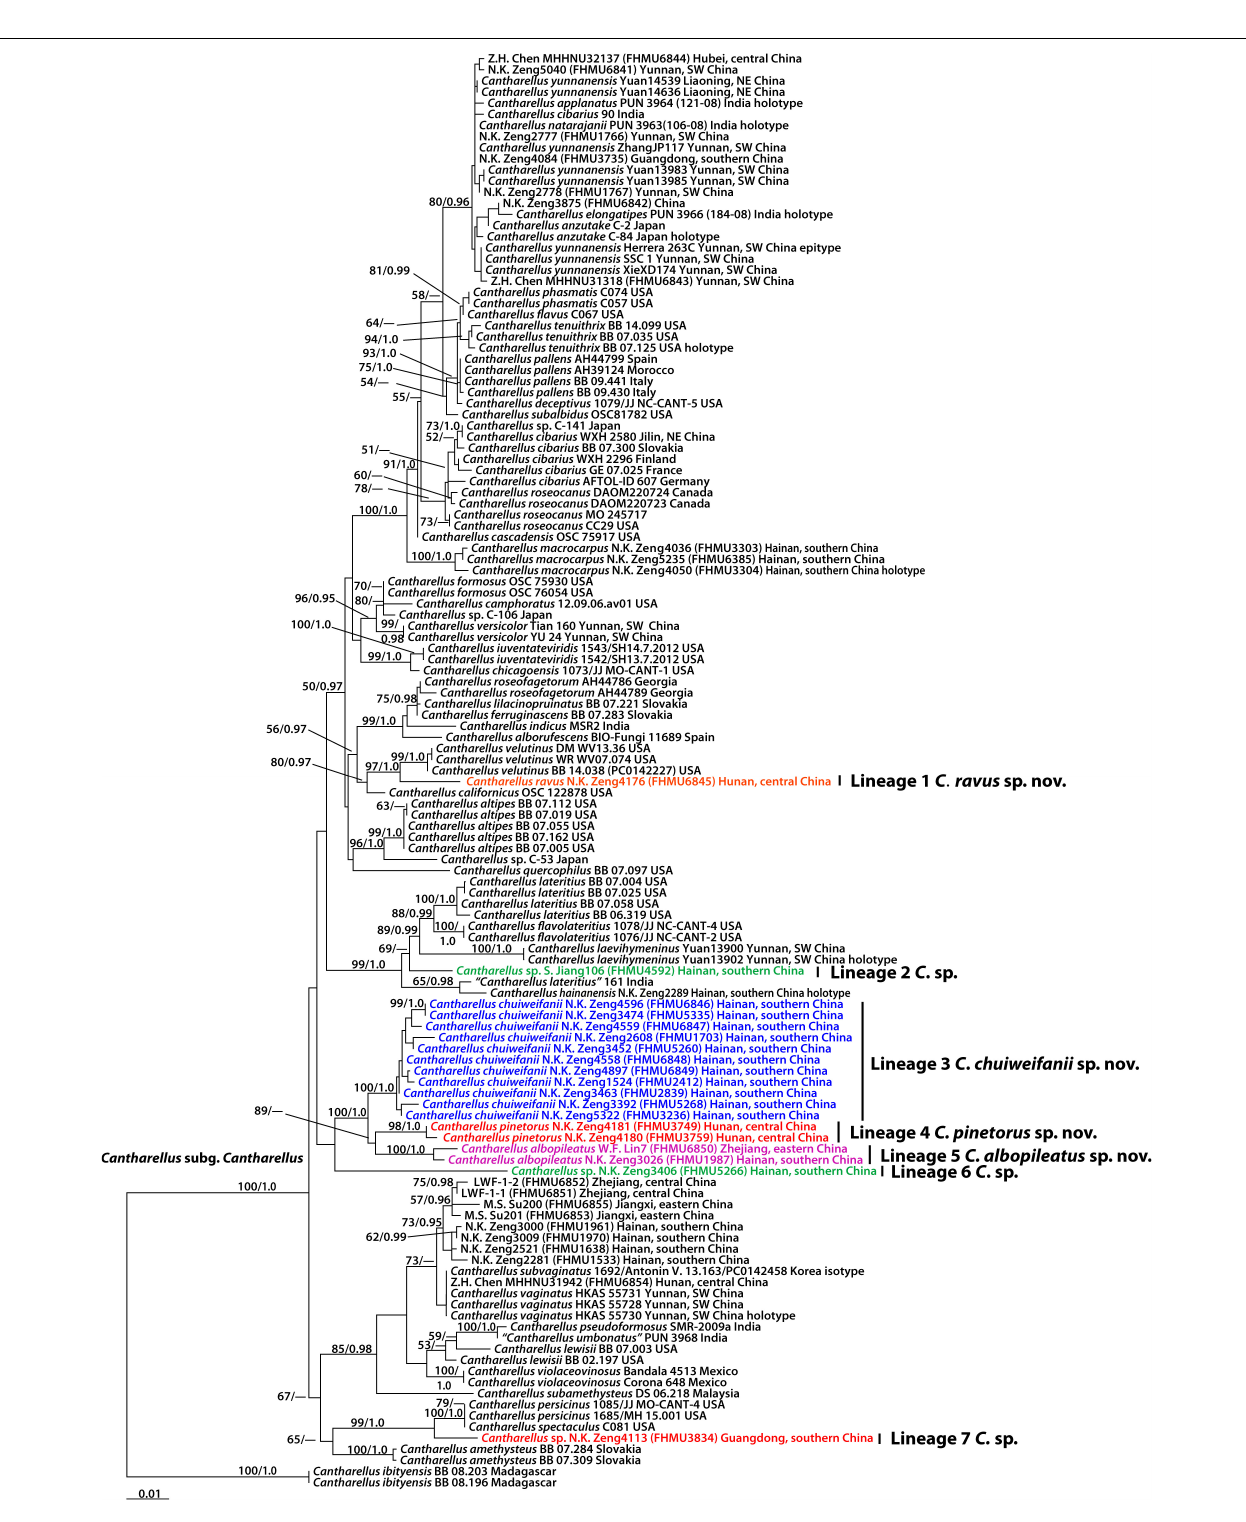
FIGURE 2 | Phylogram inferred from a combined dataset (28S and TEF1 ) of the Cantharellus subg. Cantharellus using RAxML. RAxML likelihood bootstrap (BS ≥ 50%) and Bayesian posterior probabilities (PP ≥ 0.95) are indicated above or below the branches as RAxML BS/PP.